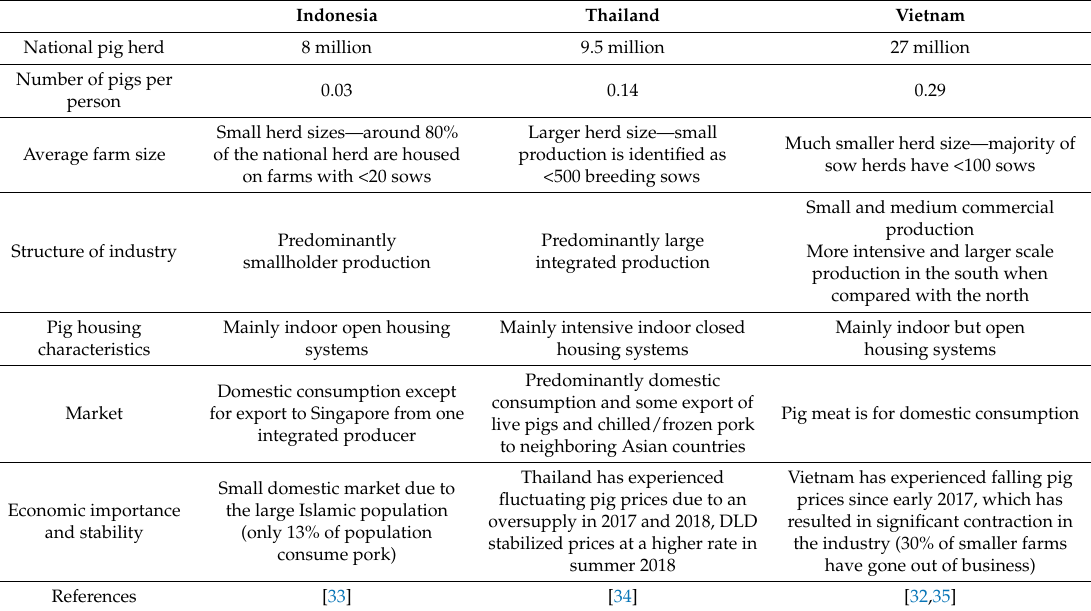
Table 2. An outline of the key characteristics of pig production in Indonesia, Thailand, and Vietnam.